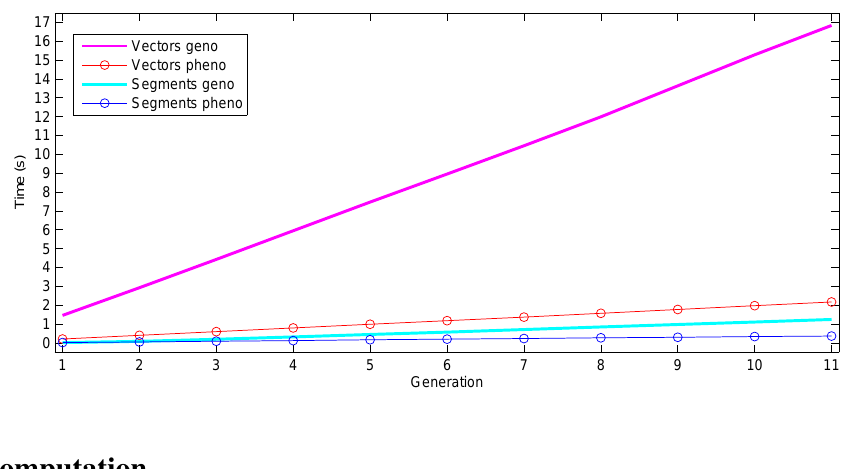
Figure 4. Time requirements of selfing the result of a cross for 10 generations, while at each generation, applying selection after computing the phenotype values. Cumulative time taken for progeny generation and phenotype computation after each generation is